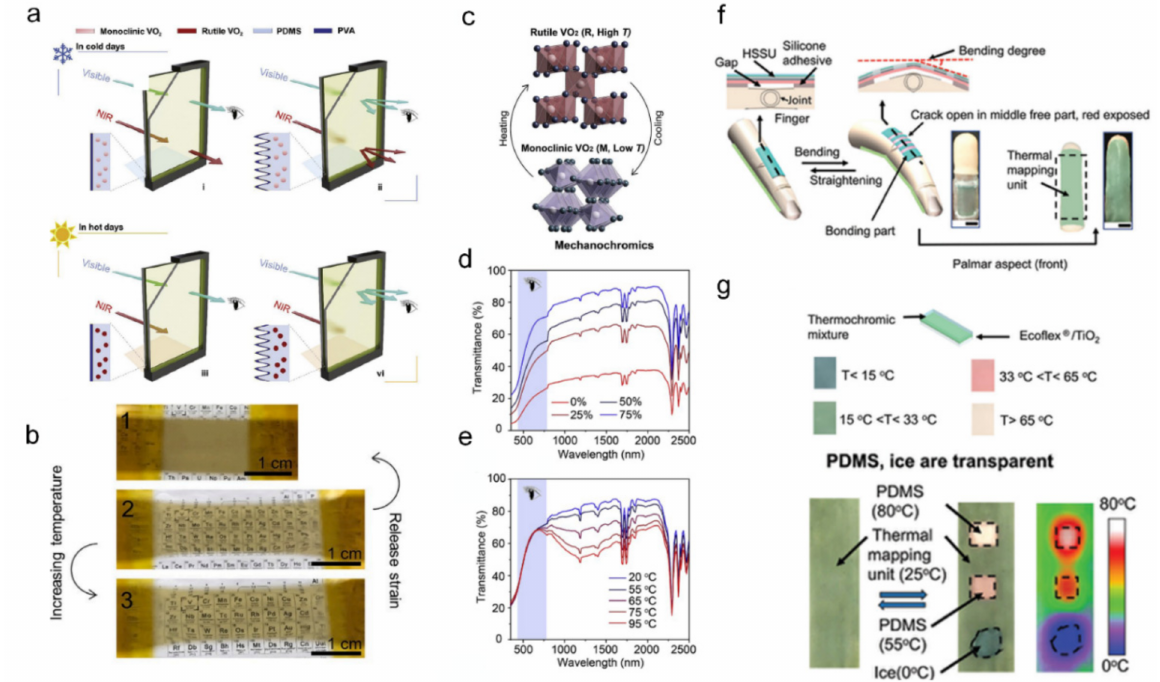
Figure 11. Multi-stimuli-responsive chromic device with a mechanical–thermal response (( a – e ) adapted with permission from ref. [121], copyright 2020 Elsevier and ( f , g ) adapted with per- mission from ref. [124], copyright 2020 The Royal Society of Chemistry). ( a ) Schematic of four different window modes for the dispersed VO 2 film in the PVA–PDMS bilayer structures; ( i ) normal, ( ii ) privacy, ( iii ) energy-saving, and ( vi ) simultaneous energy saving and privacy mode. ( b ) Demon- stration photographs of the multi-stimuli film with (1) no strain, (2) 75 % strain, and (3) temperature of 95 ◦ C. ( c ) Illustration of the VO 2 phase transition between the high-temperature rutile phase and low-temperature monoclinic phase. Transmittance spectra of the dispersed VO 2 film in the PVA–PDMS bilayer structures under privacy mode with ( d ) mechanical response and ( e ) thermal response. ( f ) Schematic and images of the wearable mechanothermal EC device on the dorsal side of a finger. ( g ) Structure and performance of the thermal mapping